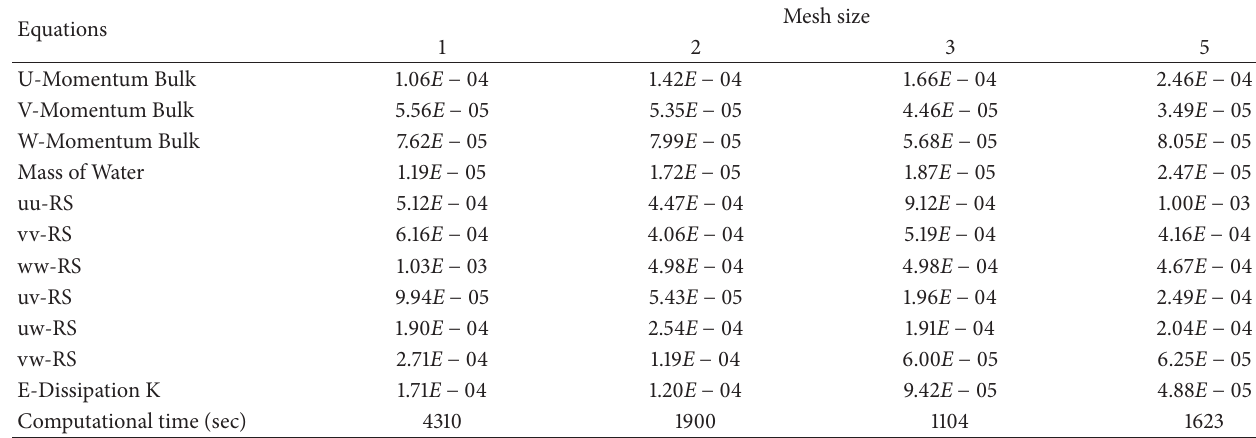
Table 4: Mesh sensitivity analysis.